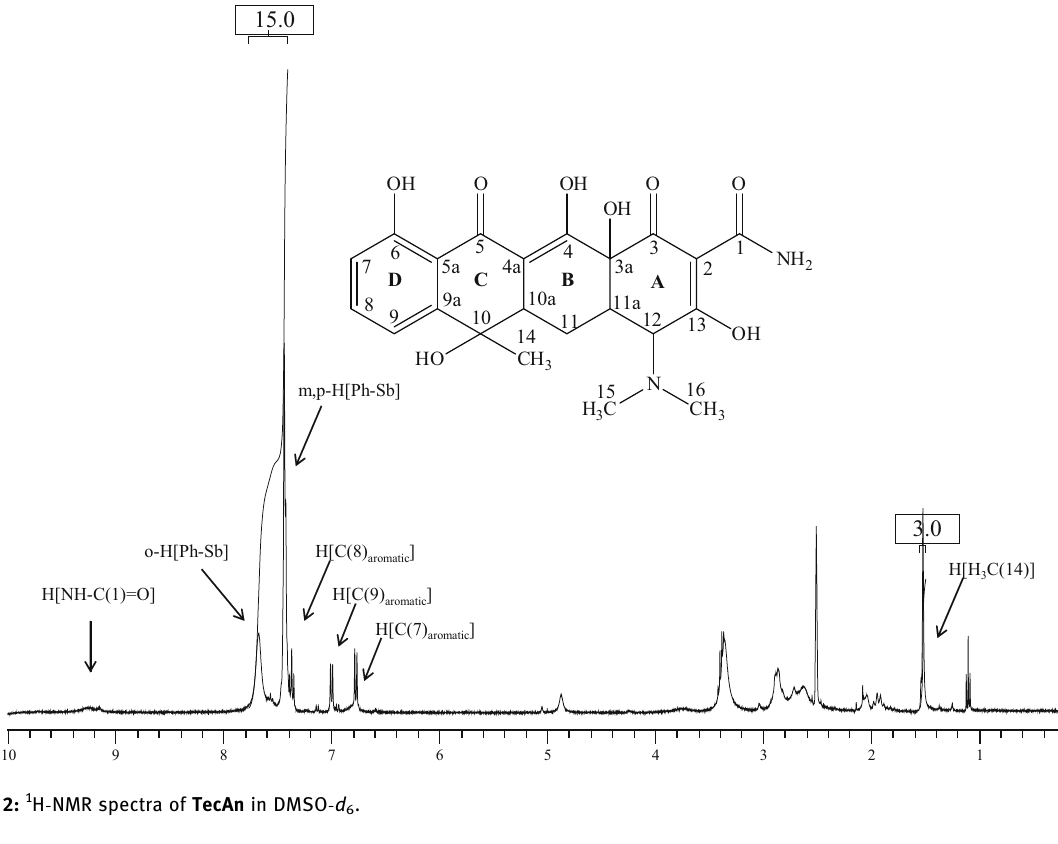
Figure 2: 1 H - NMR spectra of TecAn in DMSO - d 6 .